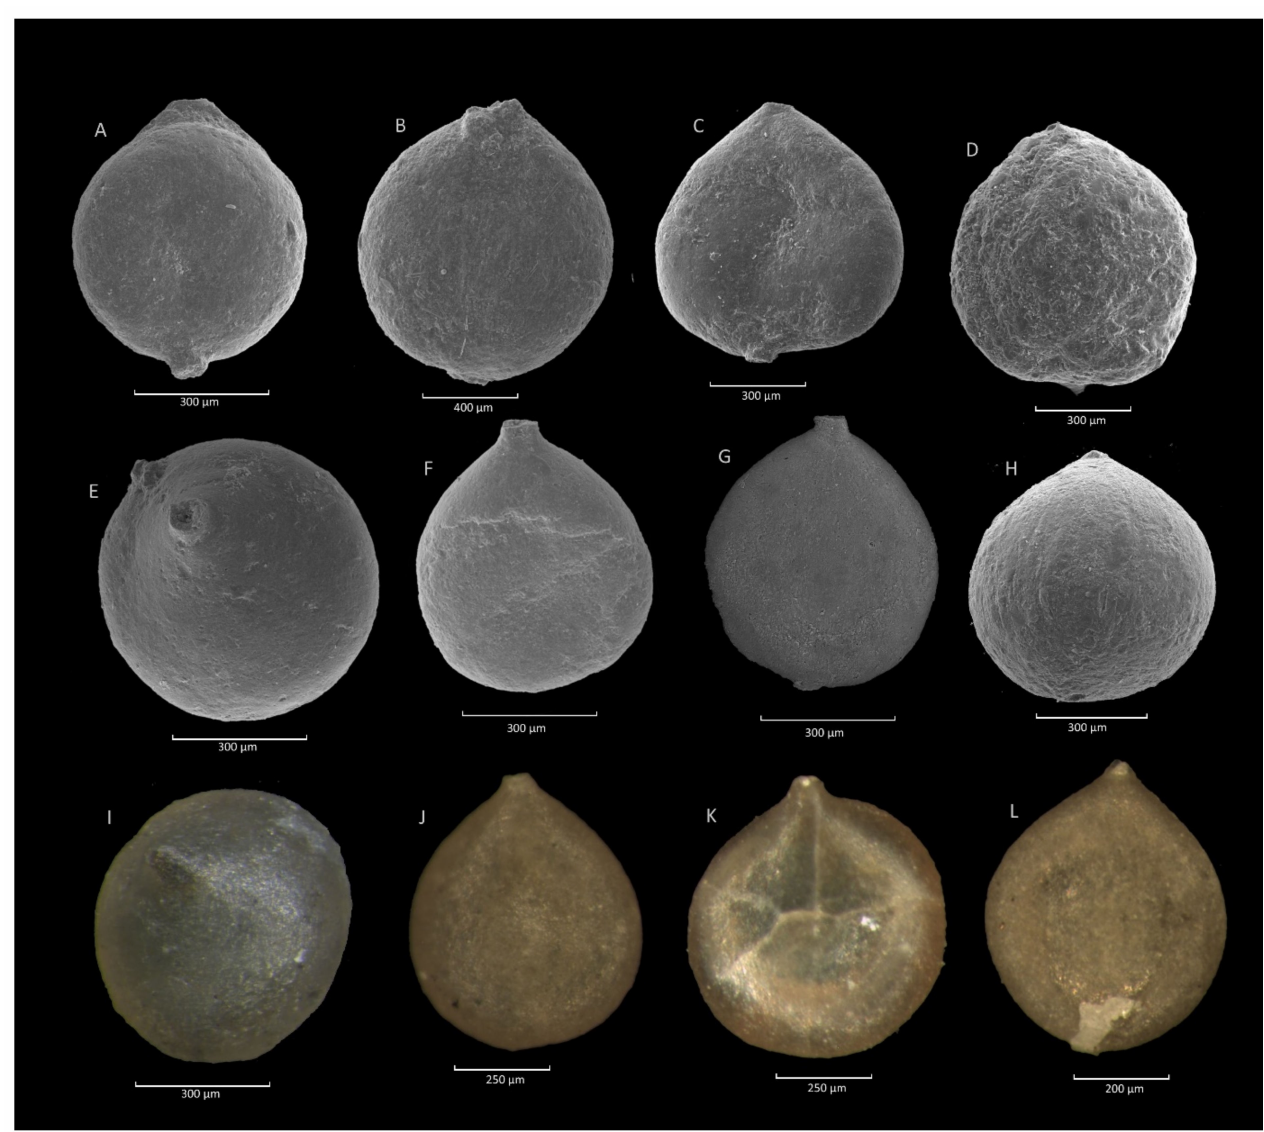
Figure 4. Caudammina gigantea Geroch. ( A – C , E , F , K ): Zimny Dział section; ( D ): Mutne section; ( G , L ): Ropica section; ( H , I ): Lubomierz section; ( J ): Jaworzynka